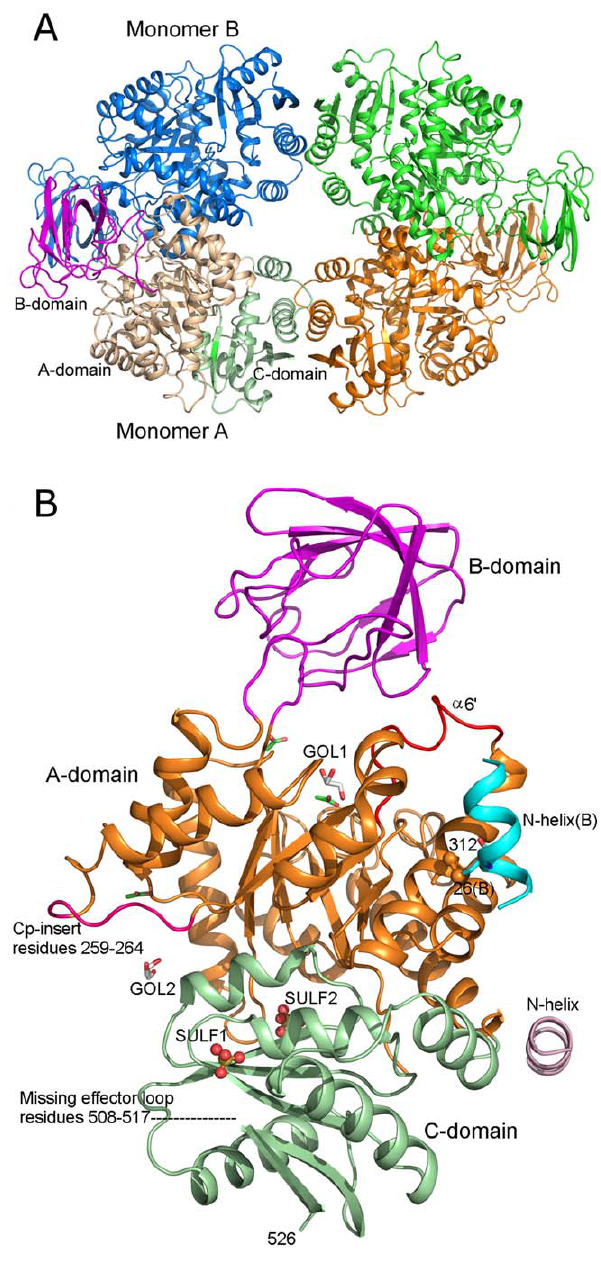
Figure 2. CpPyk tetramer and monomer. (A) The tetramer is generated by a crystallographic 2-fold axis. Domains of monomer A are colored the same as in Fig. 1. Symmetry related monomers are shown in green and orange. A minor interface is formed by the C-domains of the symmetry partners. (B) Monomer A. The domains are colored as follows: N - light pink, A - orange, B - magenta, C - light green. The two sulfate ions are labeled SULF1 and SULF2. The N-helix of the B monomer (cyan) is included in order to show the disulfide bond. The sulfur atoms in the disulfide bond between cysteine residues 26 and 312 are shown as orange balls. Glycerol and acetate ions are shown as stick models. The unwound helix a 6’ is shown in red. The location of the missing effector loop is indicated. The loop representing the Cryptosporidium-specific insertion in the primary sequence is also labeled.